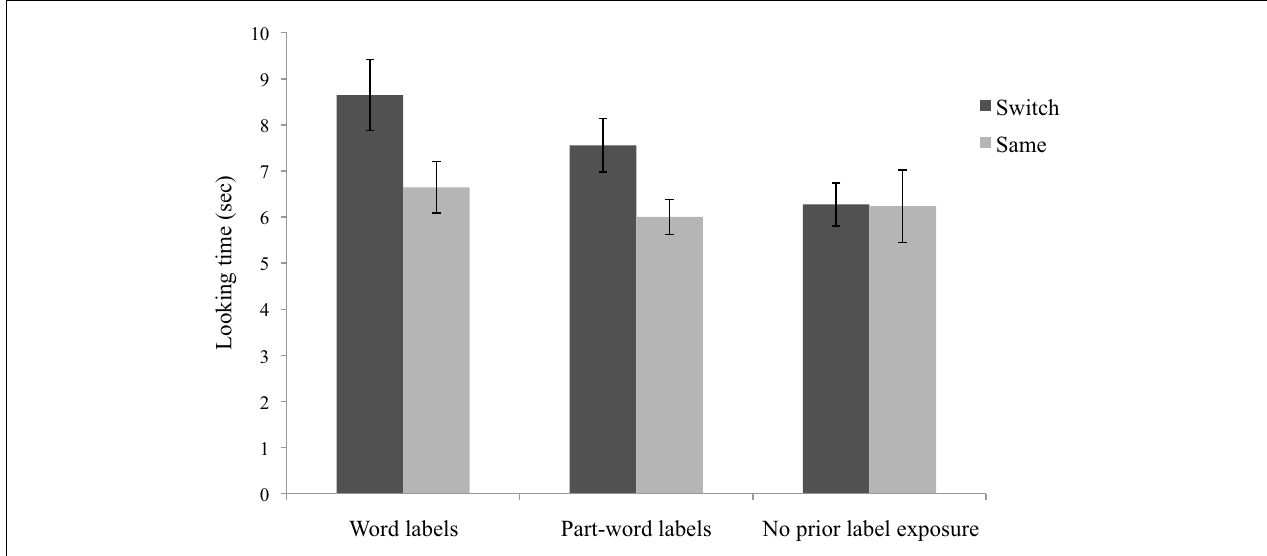
FIGURE 3 | Mean looking time (in seconds) to word and part-word labels (Experiment 2A), and labels with no prior segmentation phase exposure (Experiment 2B) to the same and switch test trials. Error bars represent standard errors.